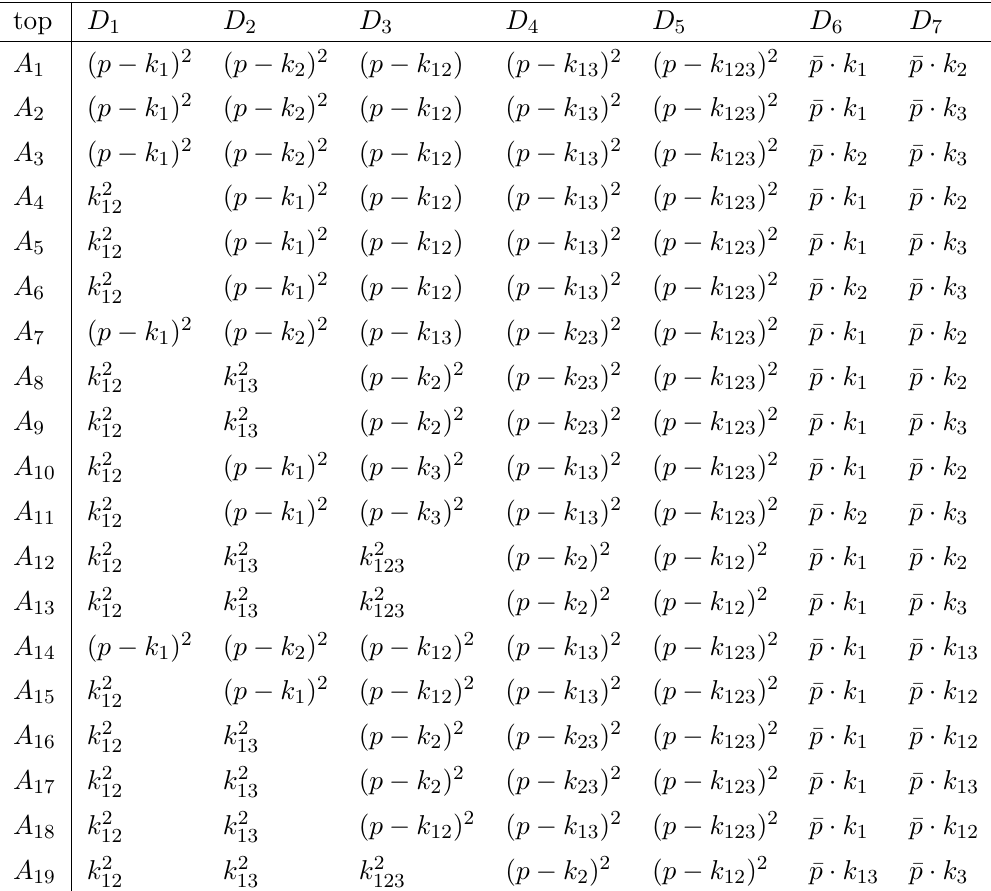
Table 1. The inverse propagators D i for each of the 19 topologies A 1 : : : A 19 . Here we use